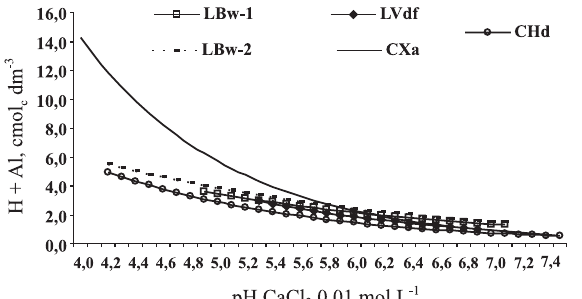
Figura 2. Relação entre os teores de acidez potencial (H + Al) e o pH em CaCl em diferentes doses de 2 CaO para o V calculado de 25, 45, 60, 70, 100, 125 e 150